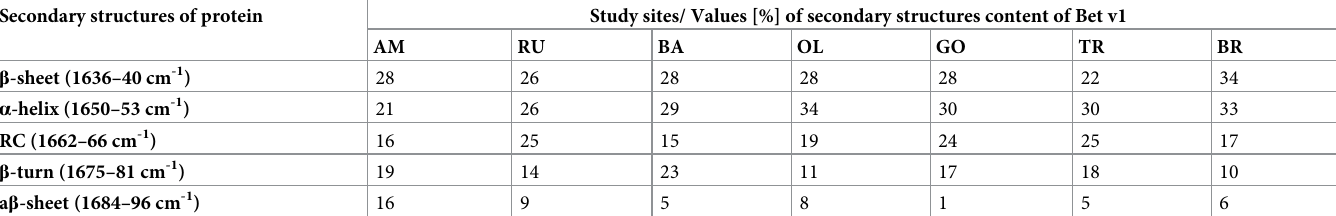
Table 3. The quantitative estimation [%] of secondary structures content of Bet v1 protein isolated from pollen of Betula pendula . collected from trees growing in particular study site in Malopolska region. Secondary structures of